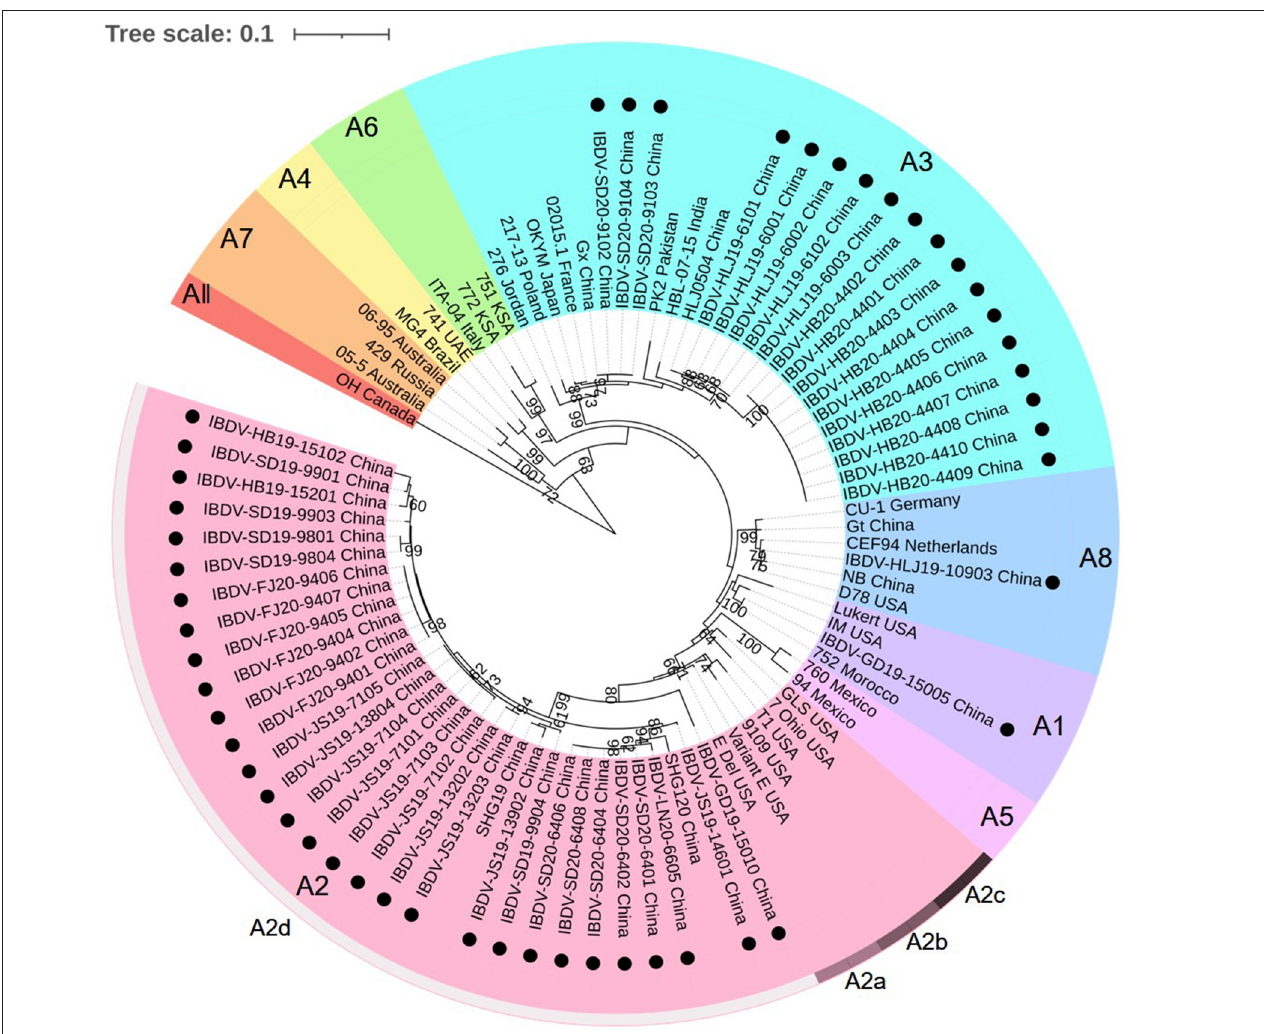
FIGURE 1 | Phylogenetic analysis of the nucleotide sequences of the hypervariable region (HVR) of the VP2 gene. The tree was generated by the Maximum-likelihood method using MEGA6 Software. The tree was visualized in iTOL. The tree was drawn to scale, with branch lengths measured in the number of substitutions per site. Only branches supported by a bootstrap value above 60% were displayed. The analysis involved 35 reference nucleotide sequences, and 50 strains detected in this study were highlighted with a solid circle (•). Nine genogroups based on HVR of the VP2 gene in segment A were